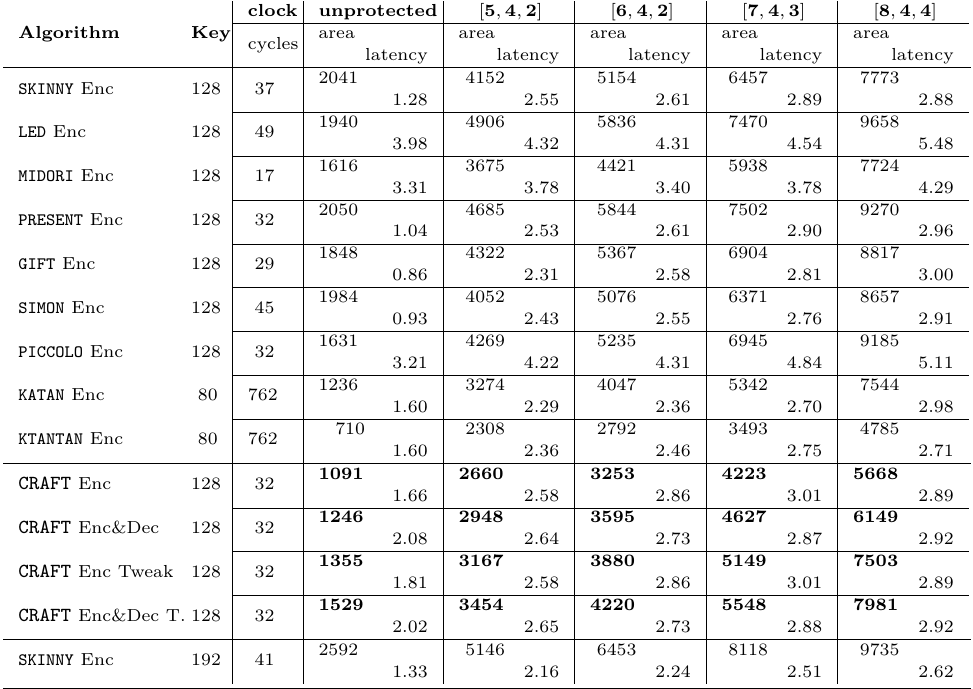
Table 10: Area (GE) and Latency (ns) comparison of round-based implementations considering an M -bounded univariate adversary with an [ n, k, d ] code, using a 40 nm t = d − 1 commercial ASIC library.